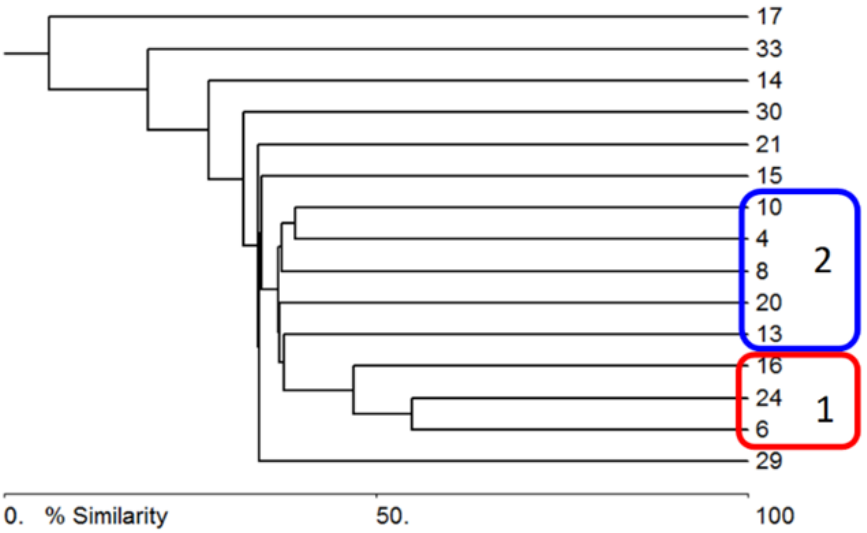
Figure 4. Bray – Curtis dendrogram of the similarity of species composition in the communities of the studied sites of South and Southeast Kazakhstan, 2019 – 2022. Cluster 1, red outline, highland sites, Cluster 2, blue outline, middle altitude sites.